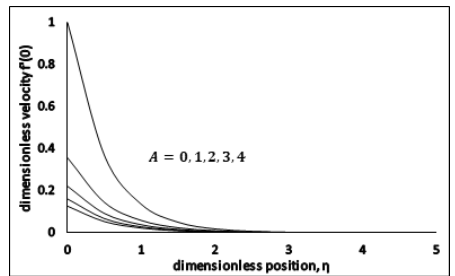
Figure 2. Dimensionless Velocity vs A